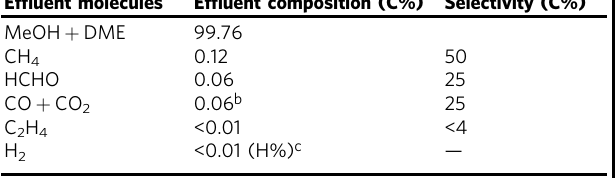
Table 1 Stream composition in methanol reaction over